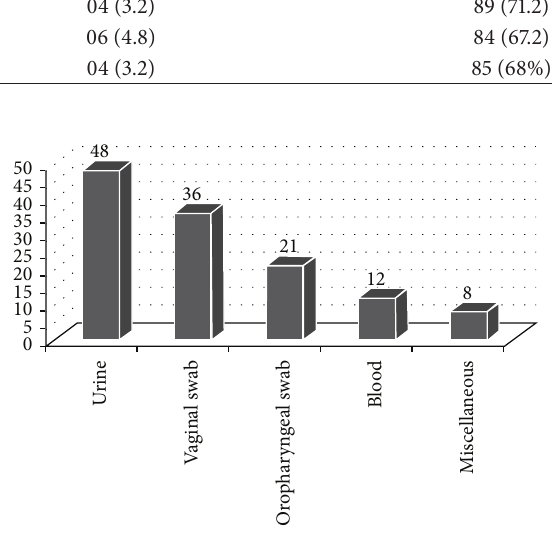
Figure 1: Sample-wise distribution of Candida tropicalis